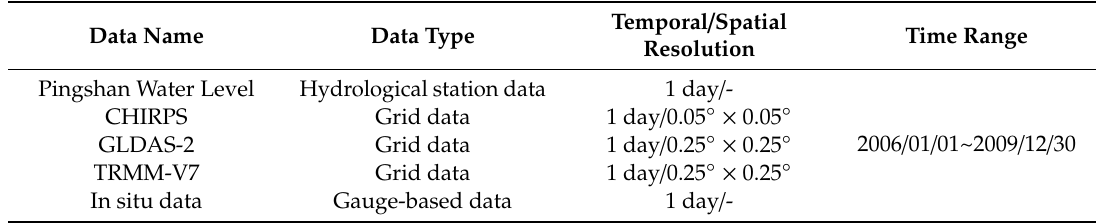
Table 1. Data list of this paper. Climate hazards group infrared precipitation with station data (CHIRPS); global land data assimilation system (GLDAS); tropical rainfall measuring mission (TRMM).